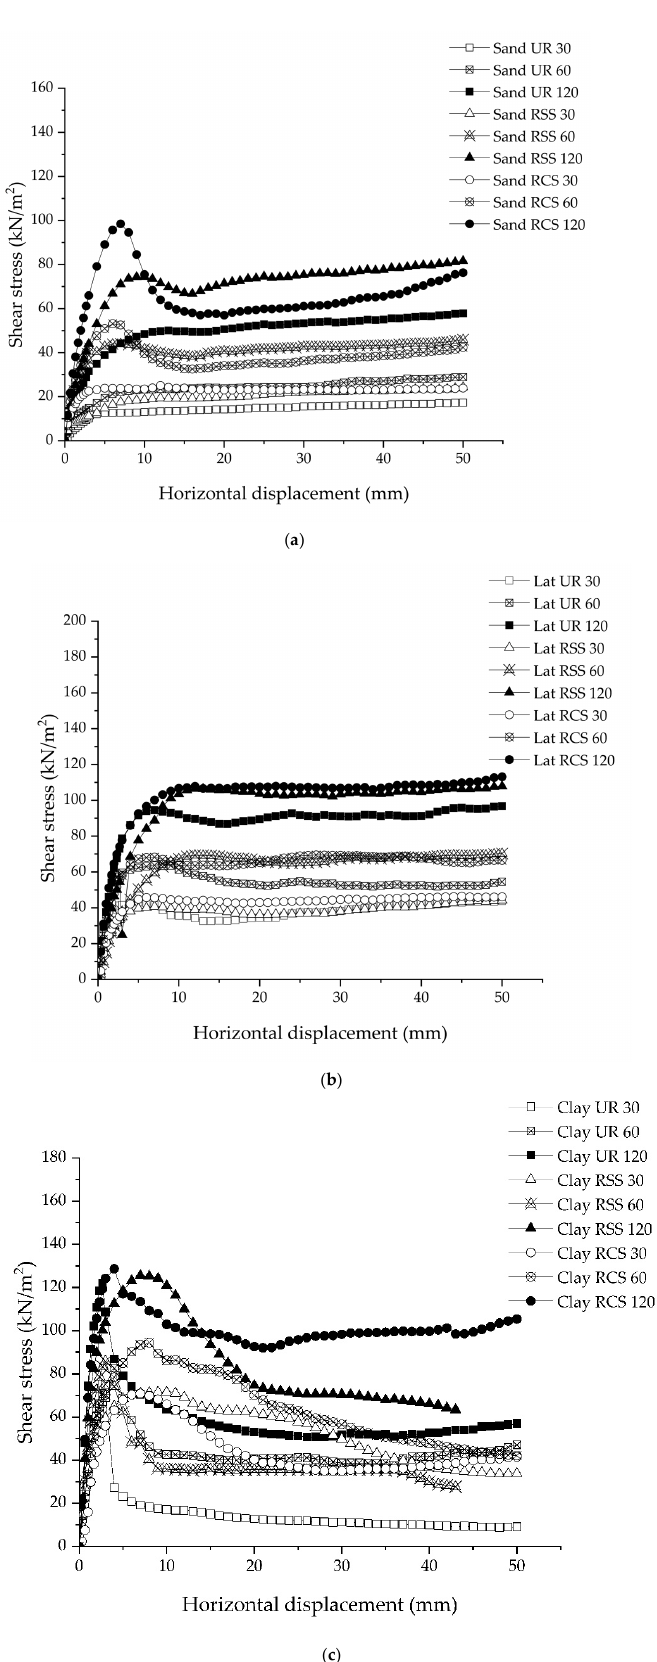
Figure 9. The relationship between shear stress and horizontal displacement of: ( a ) sand; ( b ) lateritic soil; ( c ) clay.